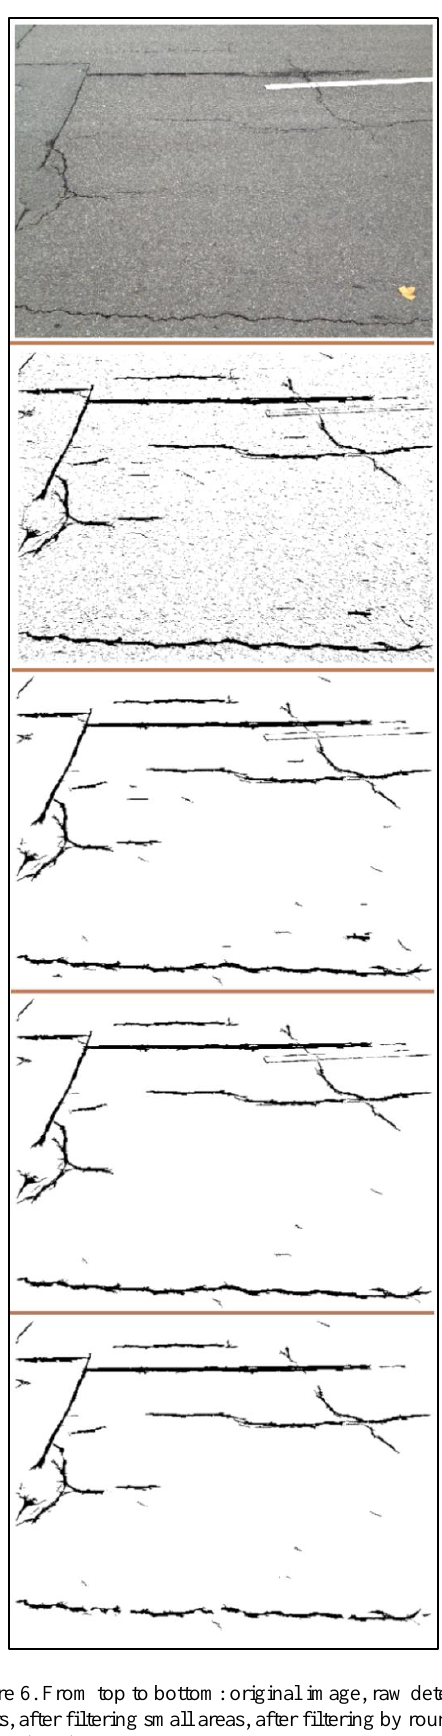
Figure 6. From top to bottom: original image, raw detection results, after filtering small areas, after filtering by roundness (0.12), after filtering boundary of road